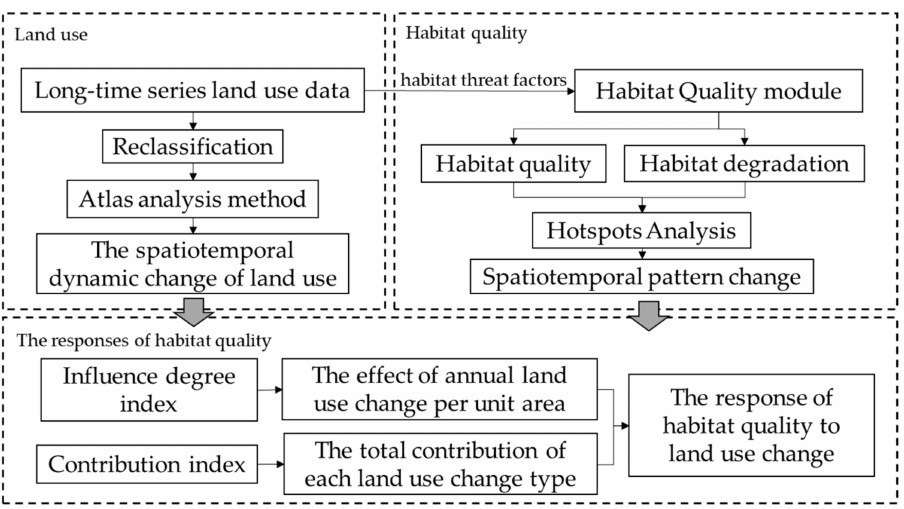
Figure 2. Illustration of the research